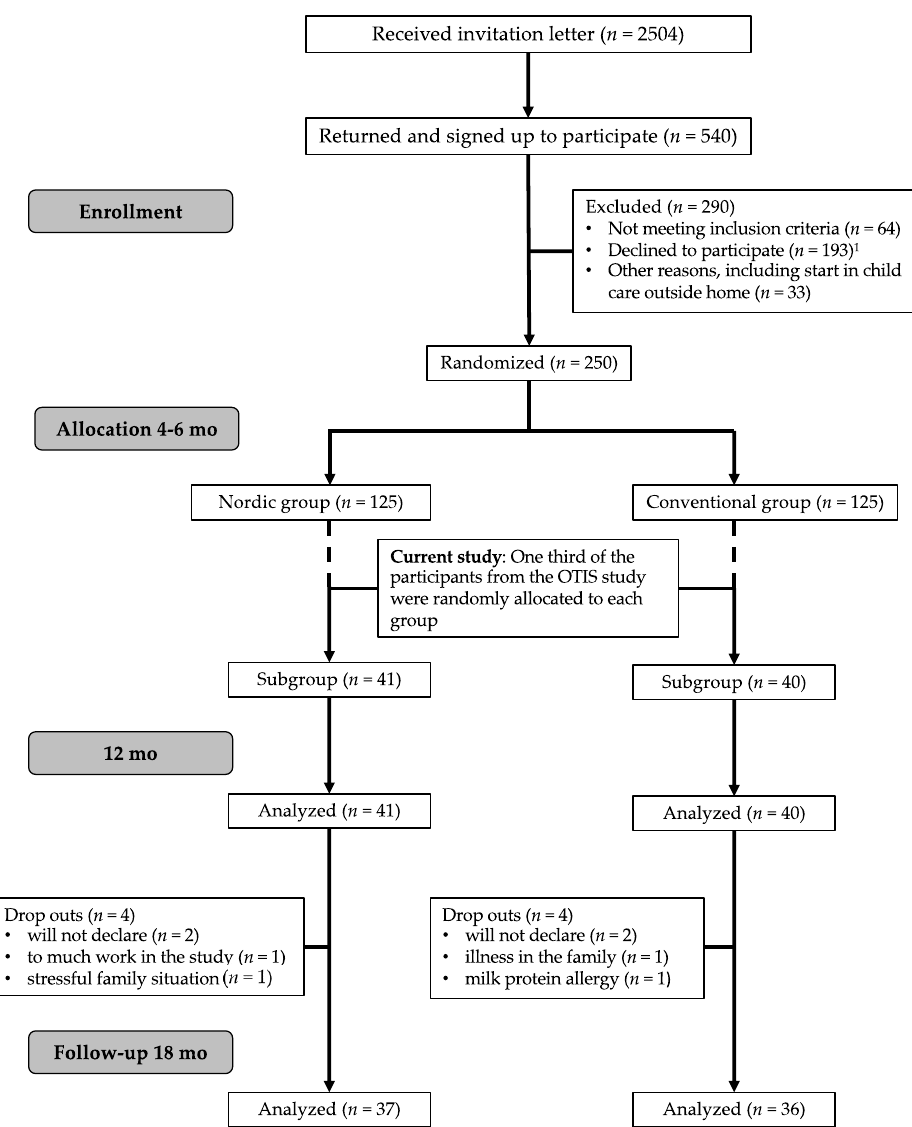
Figure 1. Flowchart of the current study in relation to the optimized complementary feeding study (OTIS) study. 1 Declined to participate; too much work in the study or too long study period or will not give their child the specific study diet.